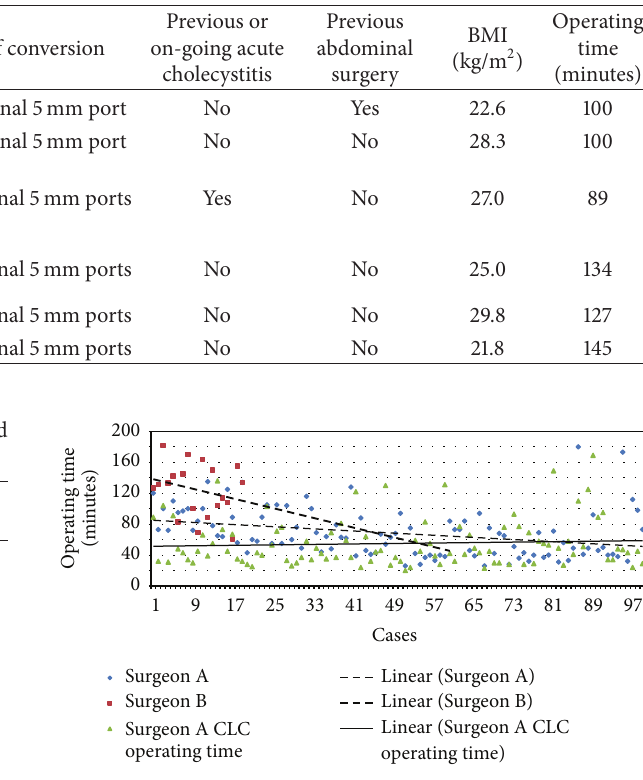
Figure 6: Trend lines of operating time of Surgeons A and B. Trend line of Surgeon B showed faster improvement in operating time with mentoring from Surgeon A.